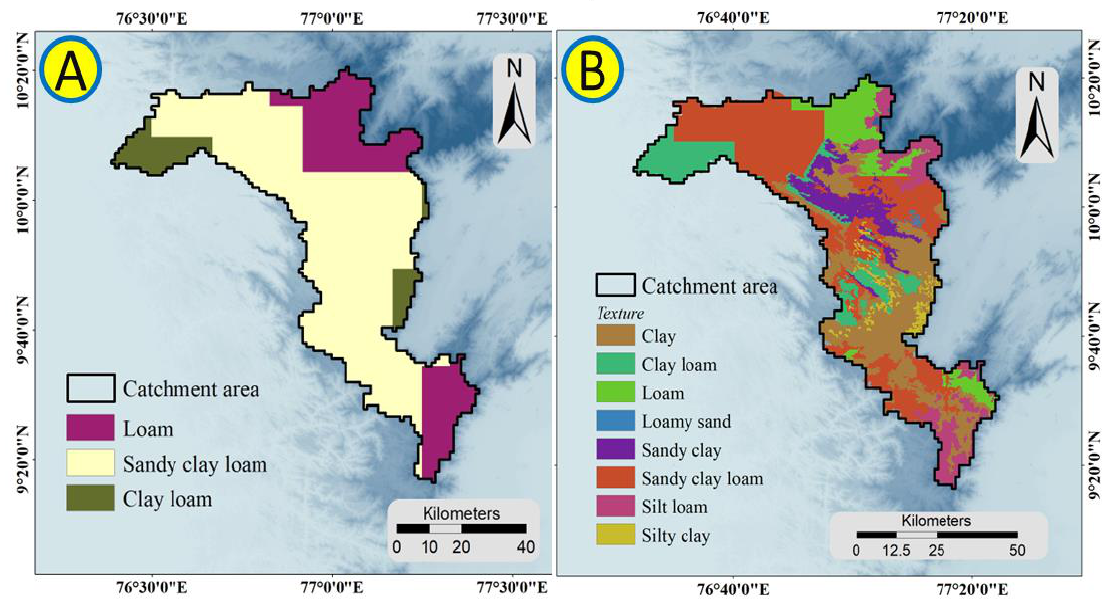
Figure 4. Soil texture map of the study area. ( A ) Soil texture based on the Global Hybrid STATSGO/FAO Soil Texture. ( B ) Field-based soil texture from Department of Soil Survey and Soil Conservation (DSSSC), Thiruvananthapuram, Kerala.